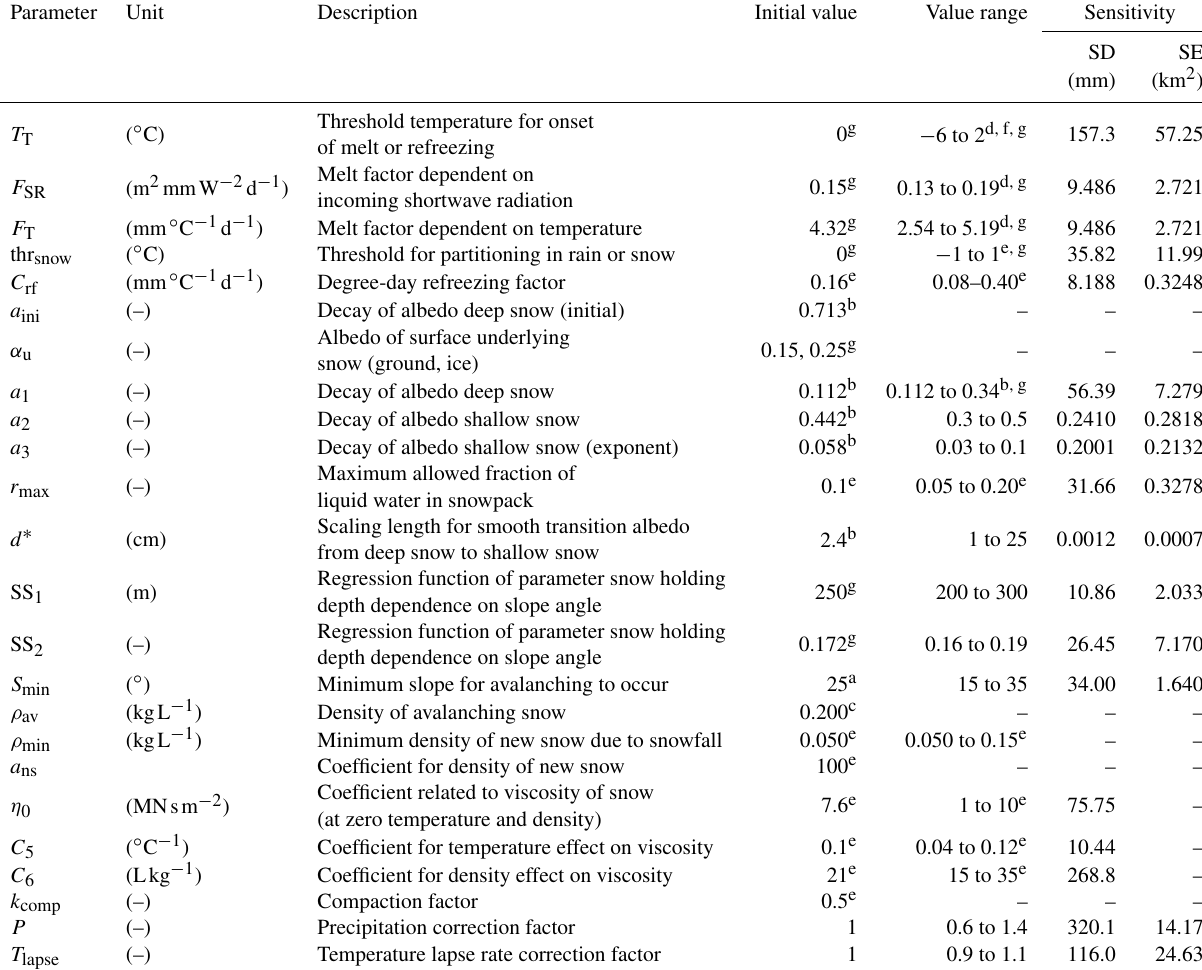
Table 2. Parameters in the snow model. Initial value indicates the uncalibrated parameter value and the value range indicates the range which is used for the sensitivity analysis. Sensitivity of snow depth (SD) and snow extent (SE) represents the difference between the 90th and 10th percentile of mean snow depth and snow extent resulting from the sensitivity